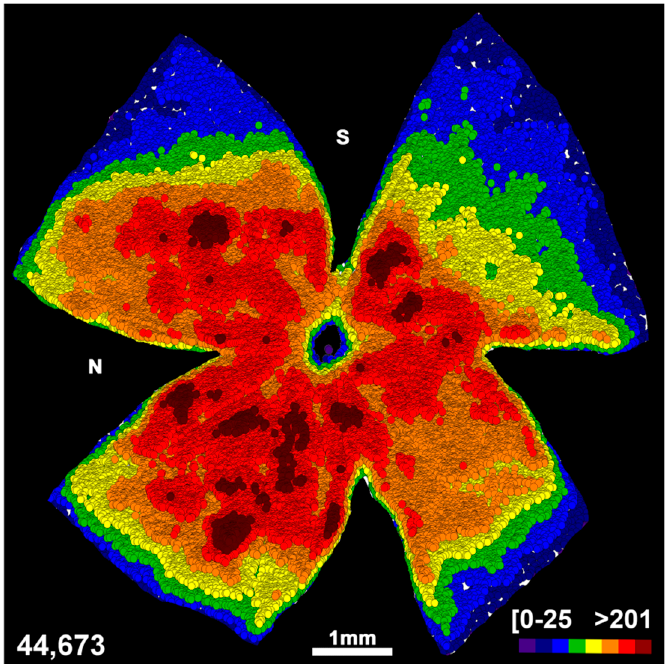
Figure 2. Retinal ganglion cell topography in intact retinas. Neighbour map illustrating the topography of RGCs in a representative intact retina. Neighbour maps illustrate the number of RGCs around a given RGC in a radius of 0.200 mm with a colour scale (bottom right) from 0–25 neighbours (purple) to >201 neighbours (dark red). The bottom left of the map shows the number of RGCs counted in the original retina. S: superior; N: nasal.